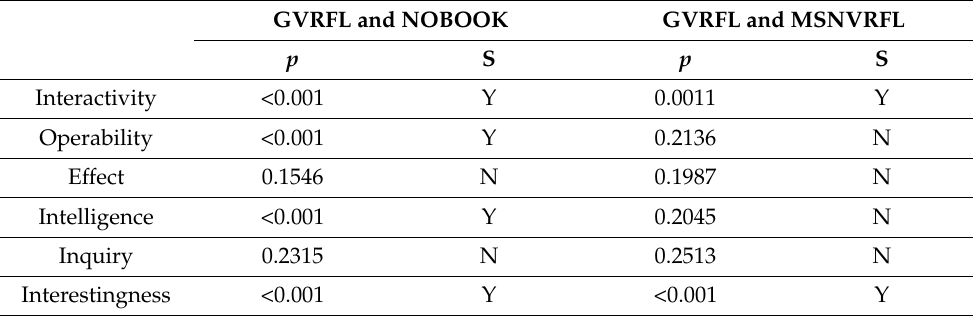
Table 3. Single-factor analysis of user